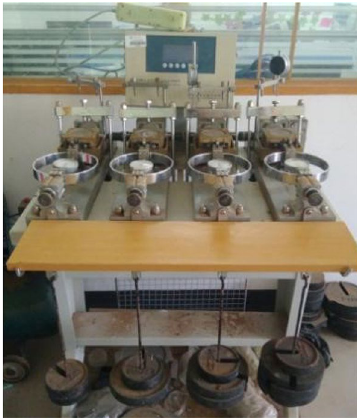
Figure 5. ZJ strain-controlled direct shear apparatus.